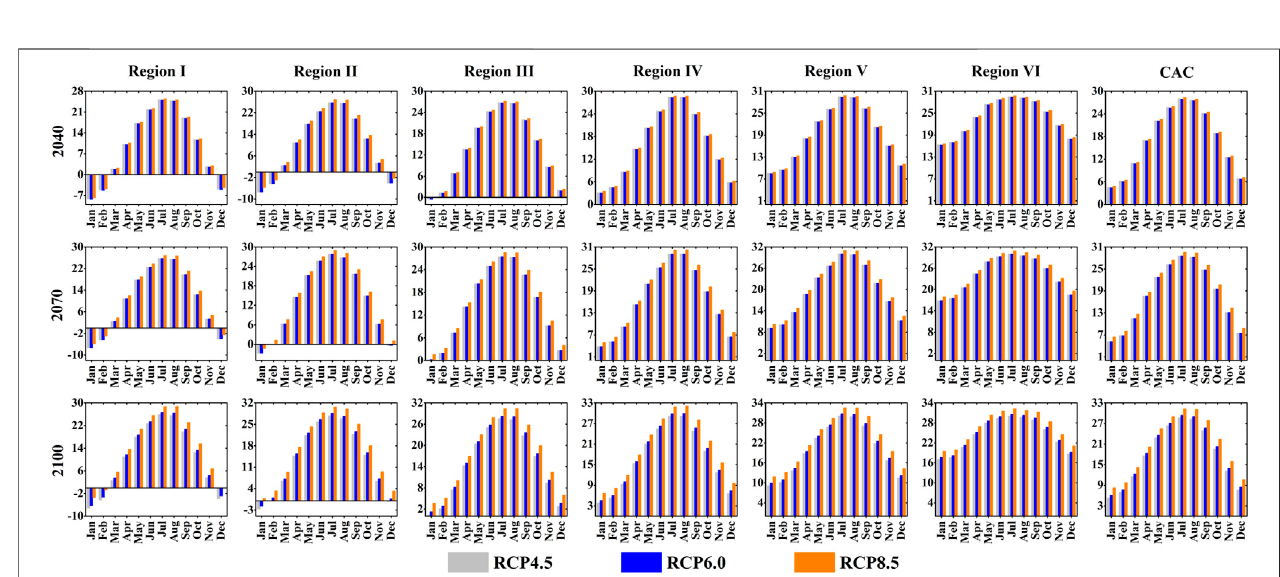
FIGURE 5 | Projected monthly average Tmean for 2040, 2070, and 2100 with different RCPs over CAC.